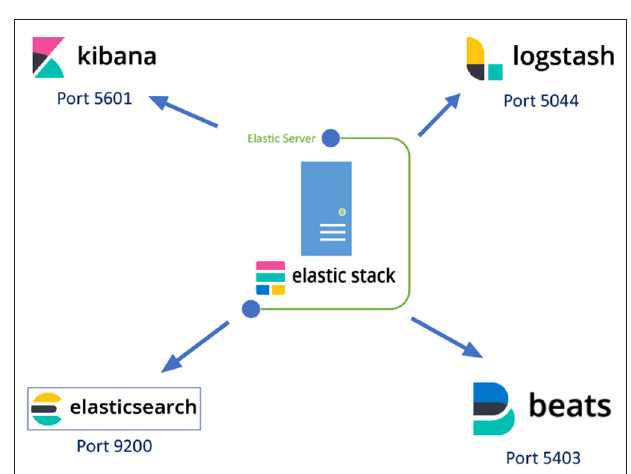
FIGURE 4 | The Elastic Stack applications and their port numbers.